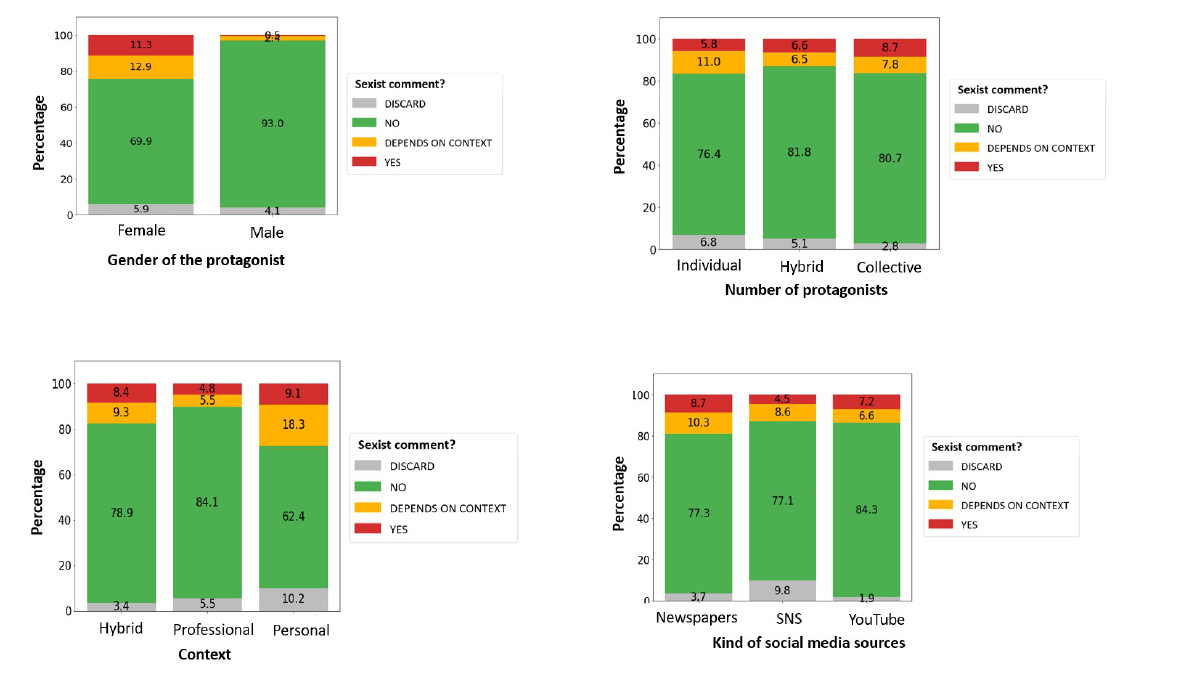
Figure 3. Characteristics of the training data